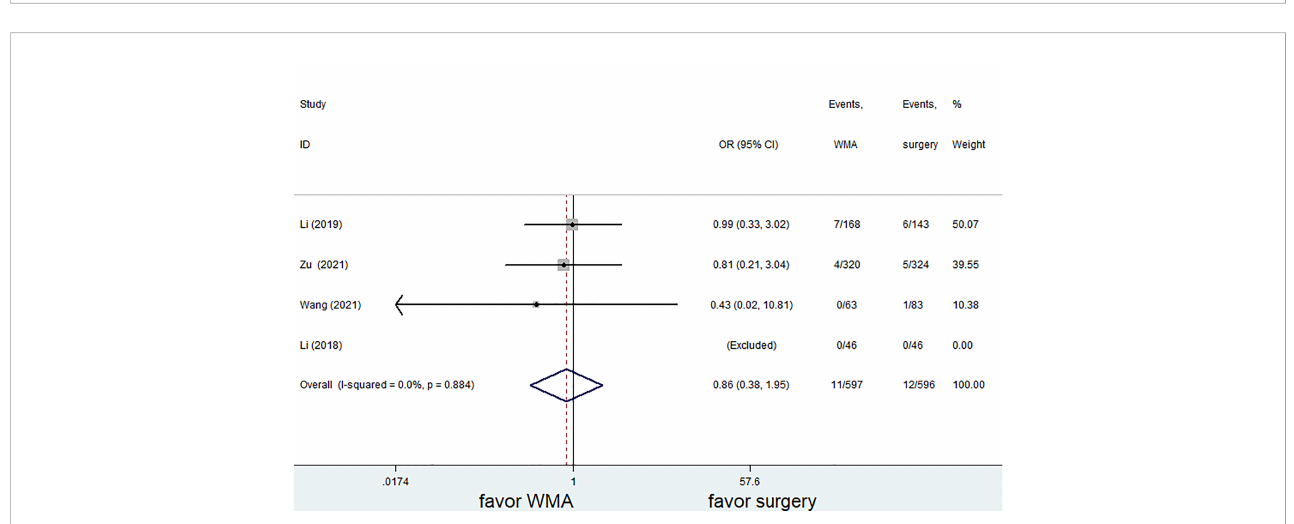
FIGURE 8 Forest plot of recurrence rates for comparing MWA with surgery in patient with PTMC. MWA, microwave ablation, PTMC, papillary thyroid microcarcinoma.